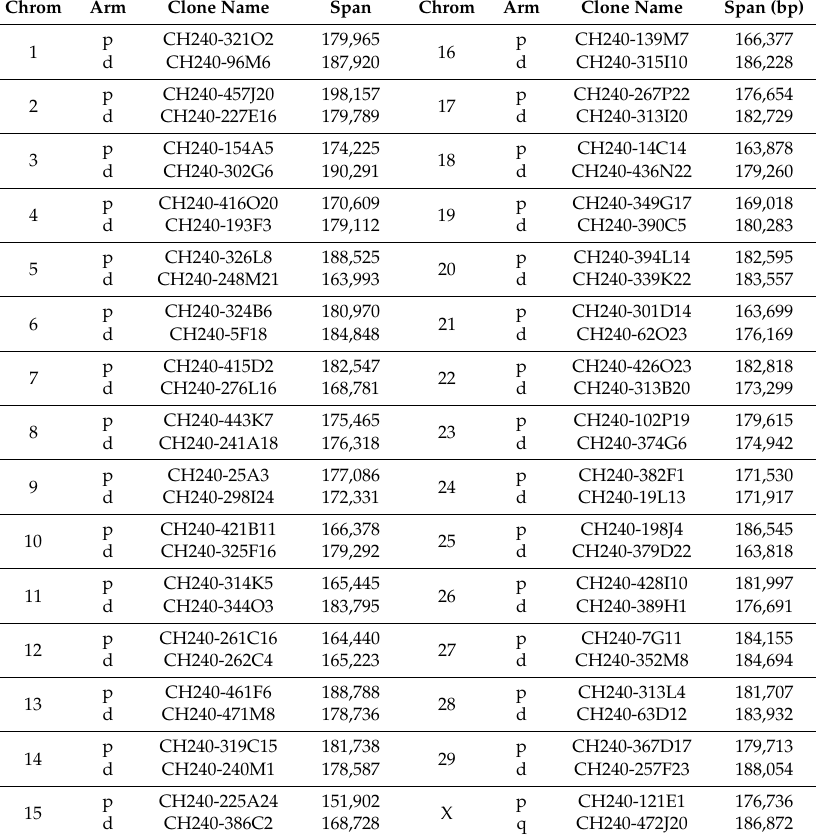
Table 1. Cattle BACs by chromosome from the CHORI-240